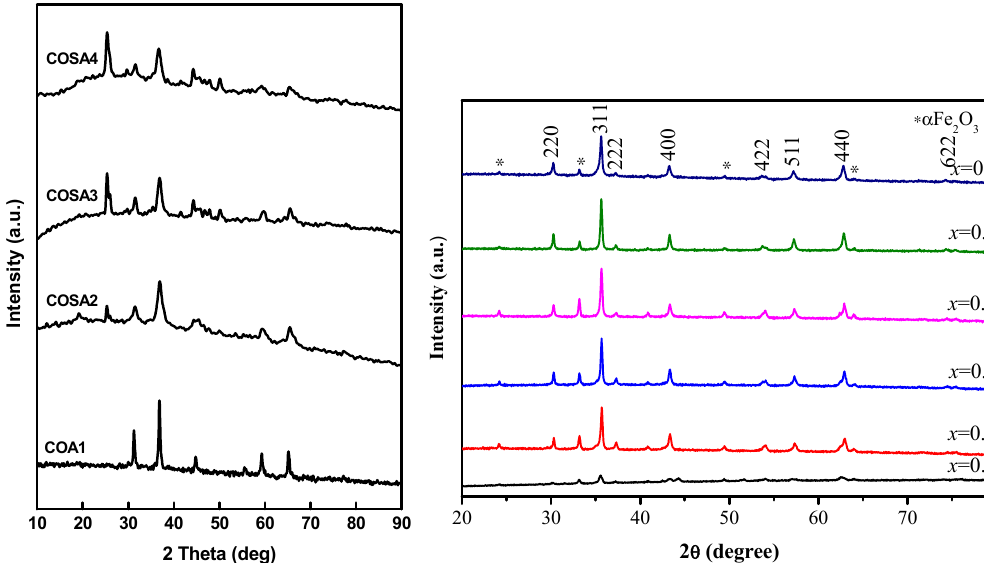
Figure 1. XRD mapping of Sr-doped CoAl 2 O 4 nanoparticles.